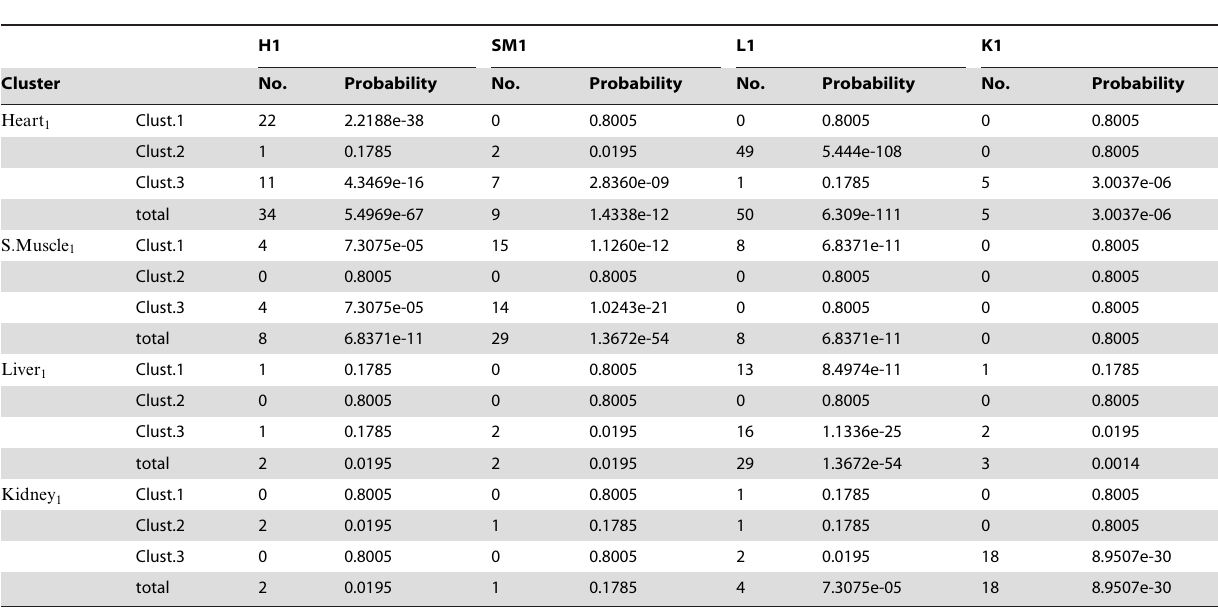
Table 4. Gene cluster comparison for indivdual tissues in the single matrix, ‘‘ tissue 1 ,’’ with the four separate tissue matrices ‘‘ tissue 4